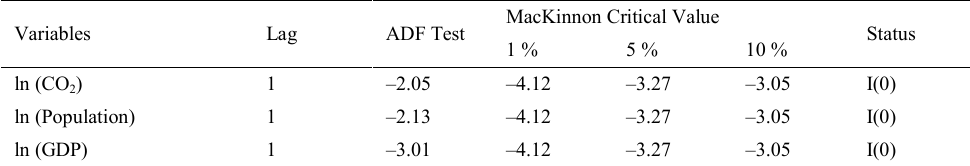
Table 1: the ADF Test Statistic at level of all variables indicates a variable unit root component or non-stationary. For instance, the calculated value from ADF is all lower than the critical value from the table at the significance level of 1 %, 5 % and 10 %. Thus, it requires the first difference to characterize the variables as Stationary. This research has shown that all stationary variables at the first differencing contain Carbon Dioxide (CO 2 ), population growth (Population growth), and Real GDP (GDP). The value from the test in accordance with “Tau-test” is greater than the all “Tau-critical” at the first difference, results can be seen in Table